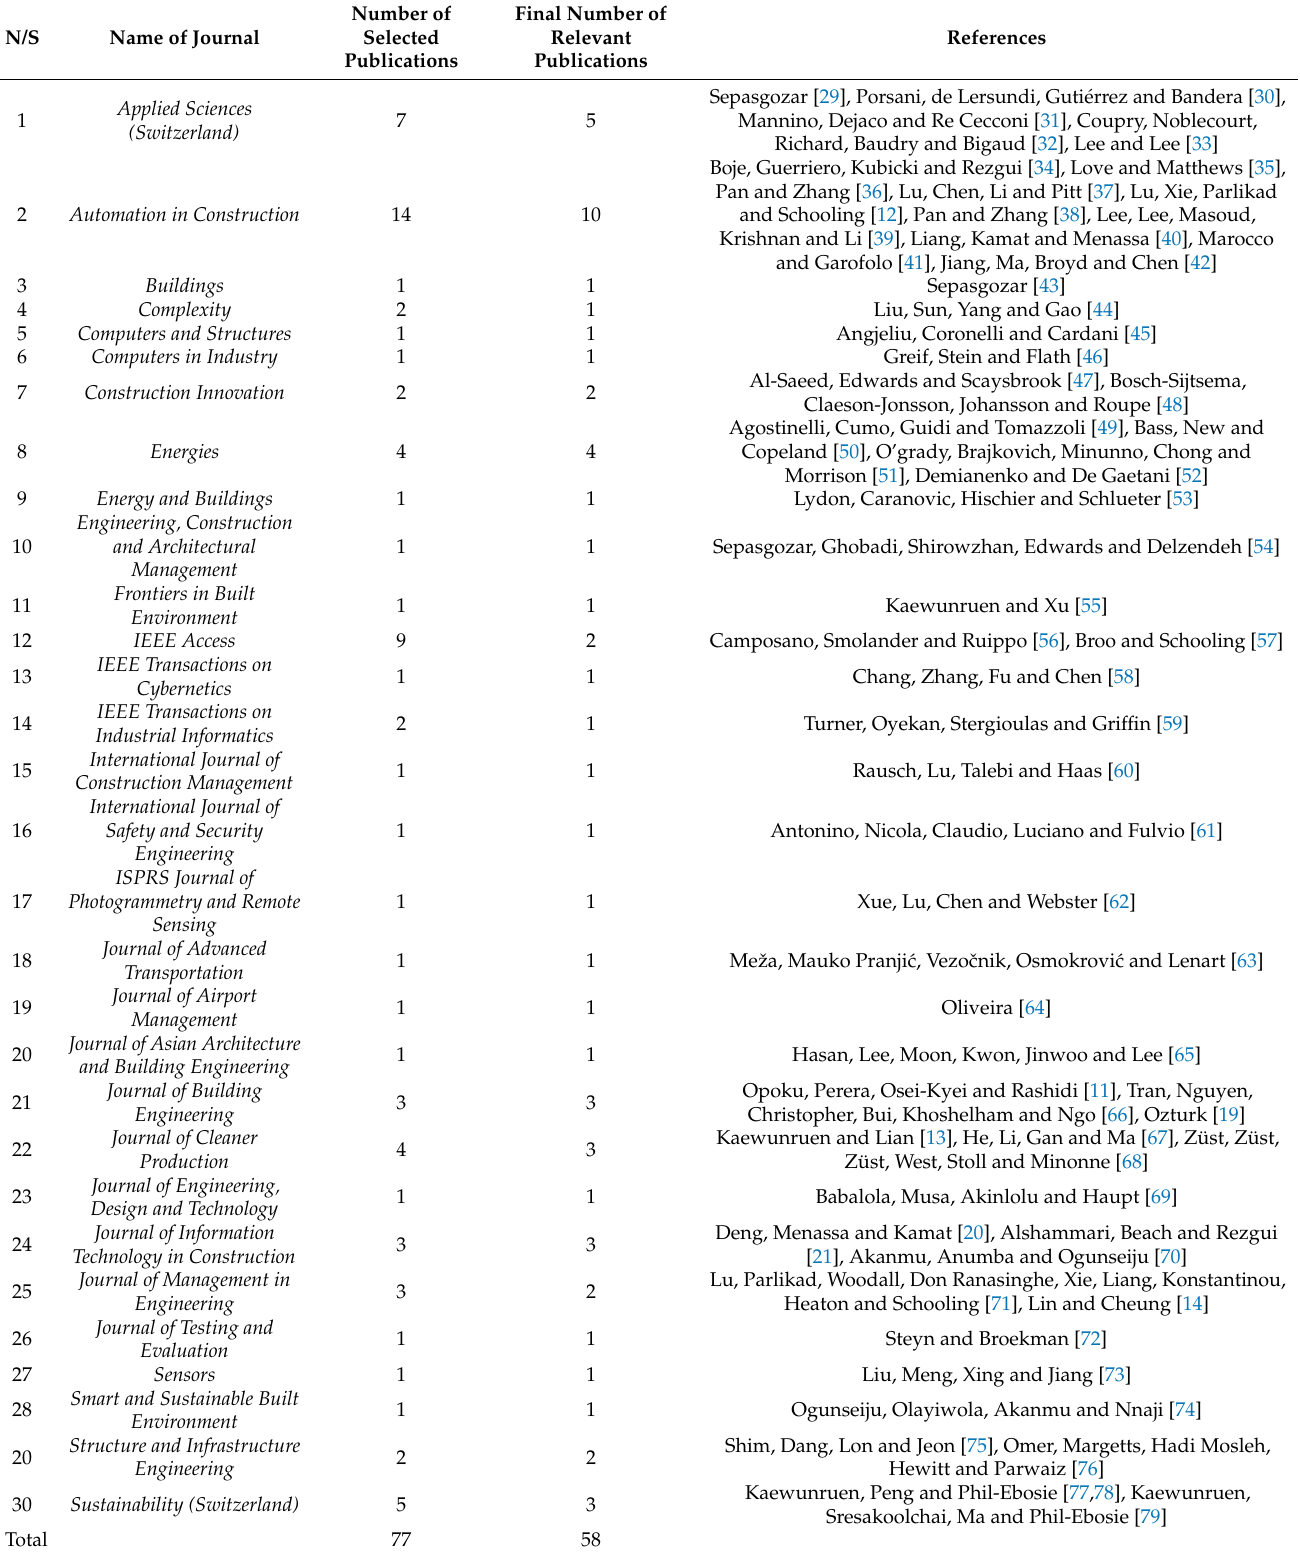
Table 1. Search results of publications relevant to the